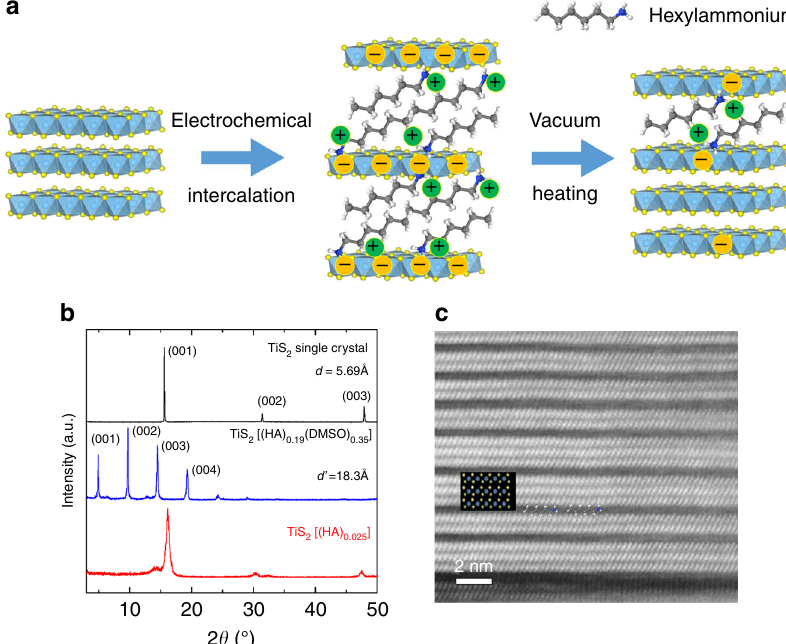
Fig. 1 a Evolution of structure and carrier concentration of TiS 2 single crystal with the electrochemical intercalation of HA molecules and vacuum heating. b XRD patterns of TiS 2 single crystal, TiS 2 (HA) 0.19 (DMSO) 0.35 and TiS 2 (HA) 0.25 , c Magni fi ed HAADF-STEM image of TiS 2 (HA)